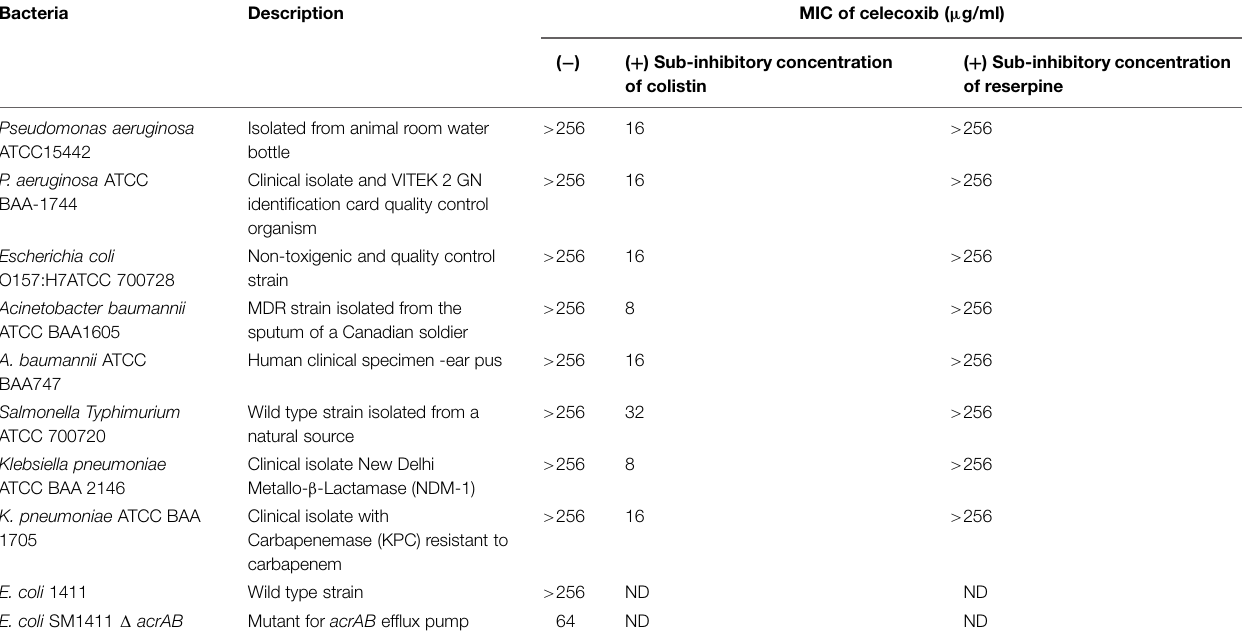
TABLE 2 | Minimum inhibitory concentration of celecoxib against Gram-negative bacteria. Bacteria